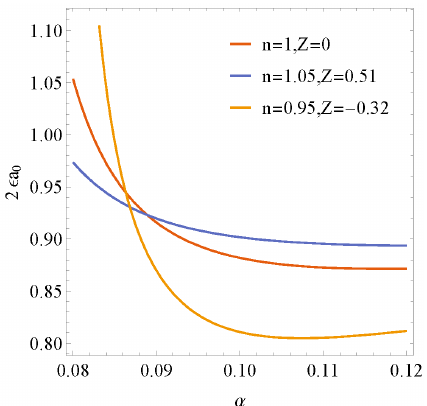
Figure 8. Nonlinear threshold finite wave amplitude in the sub ‐ critical unstable region for various n and Z with α at Re = 5. and Z with α at Re =